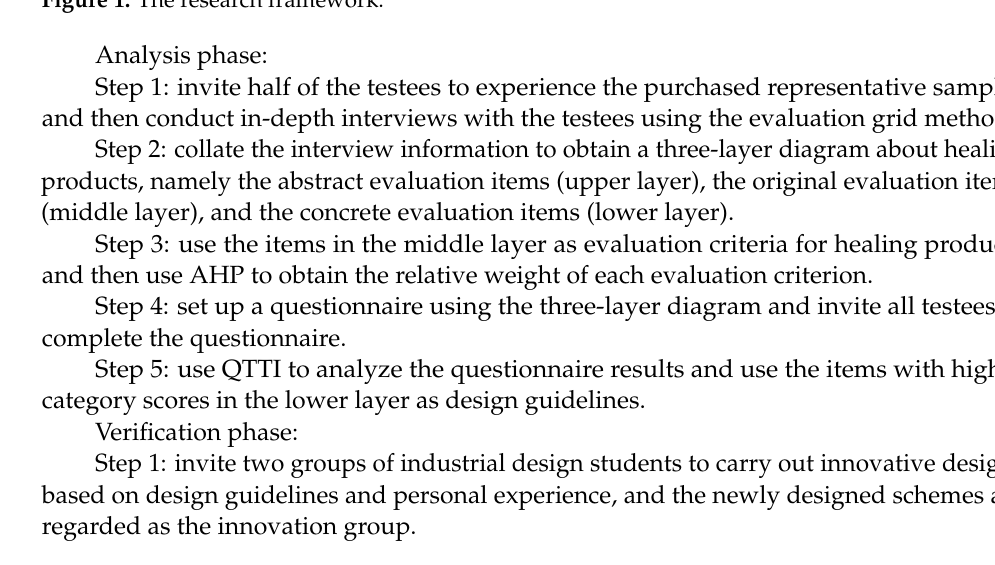
Figure 1. The research